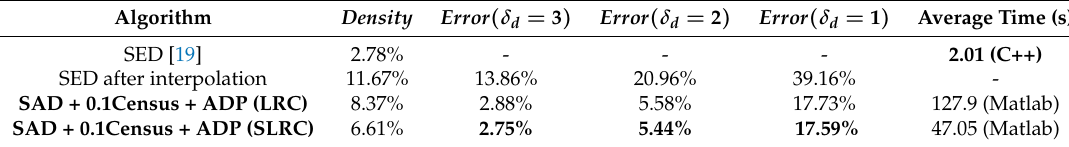
Table 3. Comparison between our method and SED